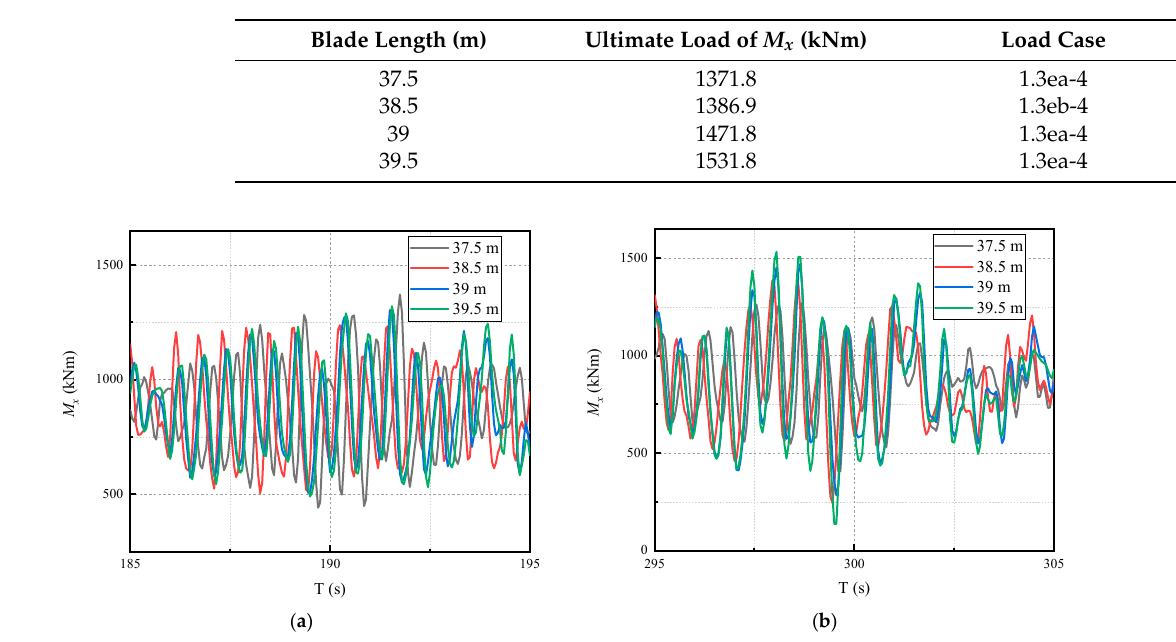
Figure 13. Load time series of M x at hub: ( a ) 185 s~195 s; ( b ) 295 s~305